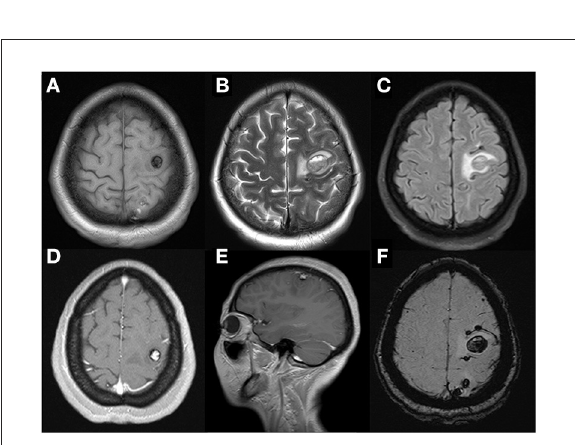
FIGURE2 Cerebral MRI examination showed multiple cerebral tumors with recent hemorrhage on axial T1WI (A) and T2WI (B) and perilesional edema on FLAIR-weighted images (C) . Enhanced T1WI after gadolinium showed the largest heterogeneous single-nodular enhancement lesion in frontal lobe on axial (D) and sagittal panel (E) . That left dispersive presence of multiple focal regions of susceptibility-induced signal loss of variable size on axial SWI (F)